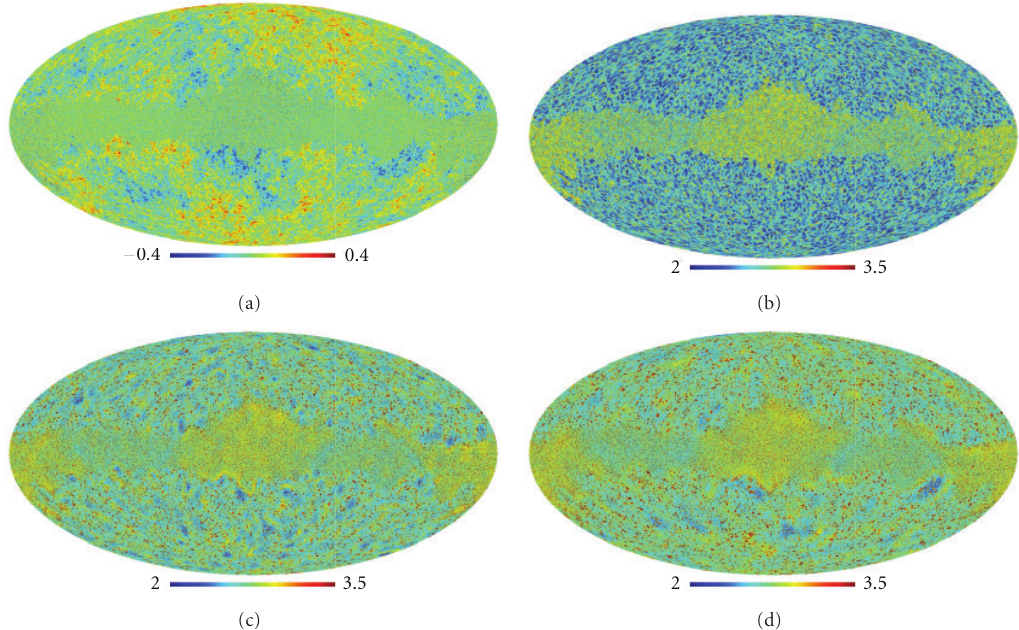
Figure 2: A simulated CMB map, in which the central regions were masked out and filled with nearly white noise, whereby the spatial noise patterns are preserved (see Section 3.1) (a), and its scaling index responses α ( (cid:2) p i , r ) for three di ff erent scaling ranges: r = 0 . 05 (b), r = 0 . 15 (c), and r = 0 . 25 (d). Di ff erent values of α ( (cid:2) p i , r ) correspond to di ff erent types of structure in the underlying map. Small scaling ranges examine the behaviour of the small structures, while the characteristics of the larger structure displayed by the higher scaling ranges. Note the di ff erent structure inside and outside the masked region of the simulated map, which is clearly identified by the scaling indices. These maps (and all following ones) are shown in a conventional scheme, namely, the Mollweide projection in the galactic reference frame with the Galactic Centre at the centre of the image and the longitude increasing from there to the left-hand